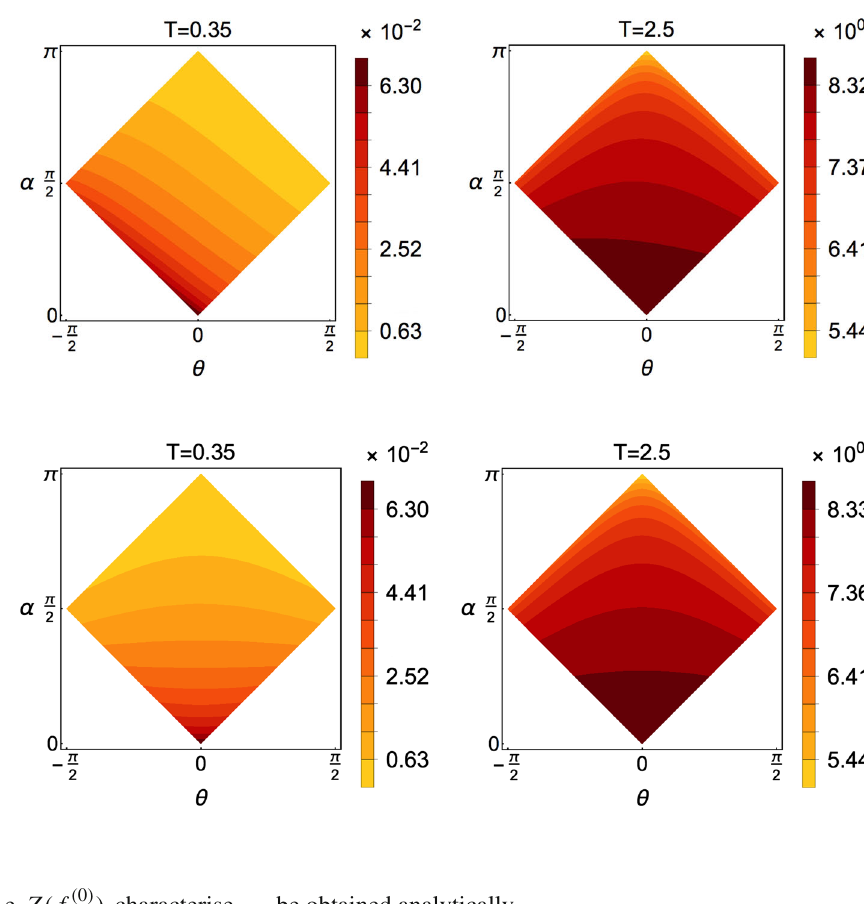
Fig. 7 Entropy per unit area for low (left) and high (right) temperatures with n 1 = 0 . 75. In these plots L = 1